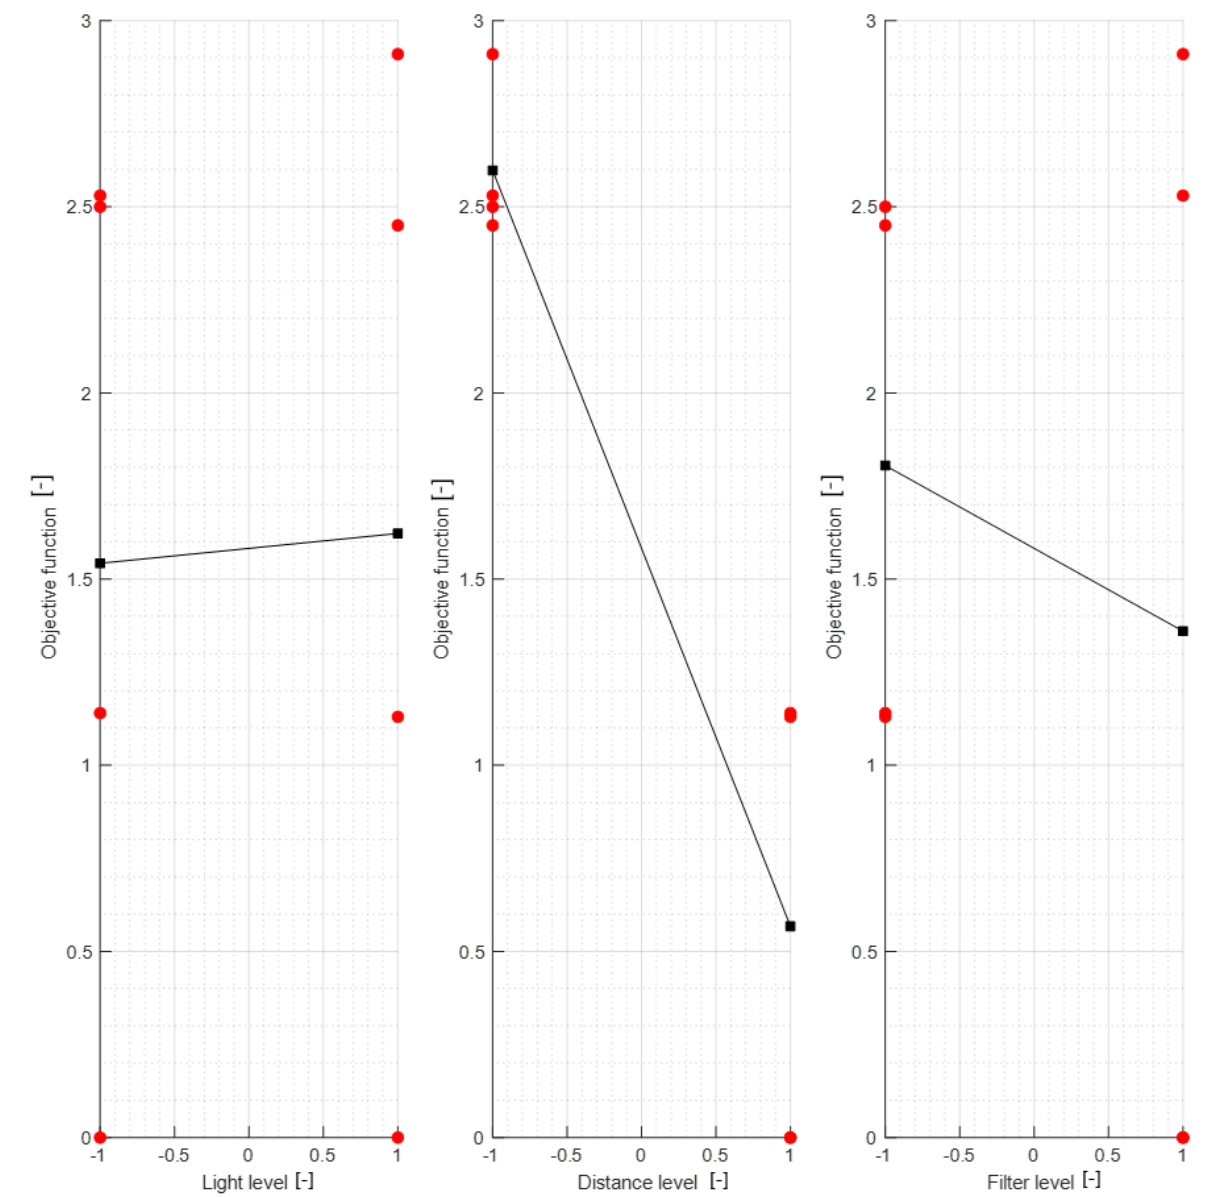
Figure 6. Parameters ’ influence on the objective function value. The red points correspond to the values on the boundary conditions before averaging.